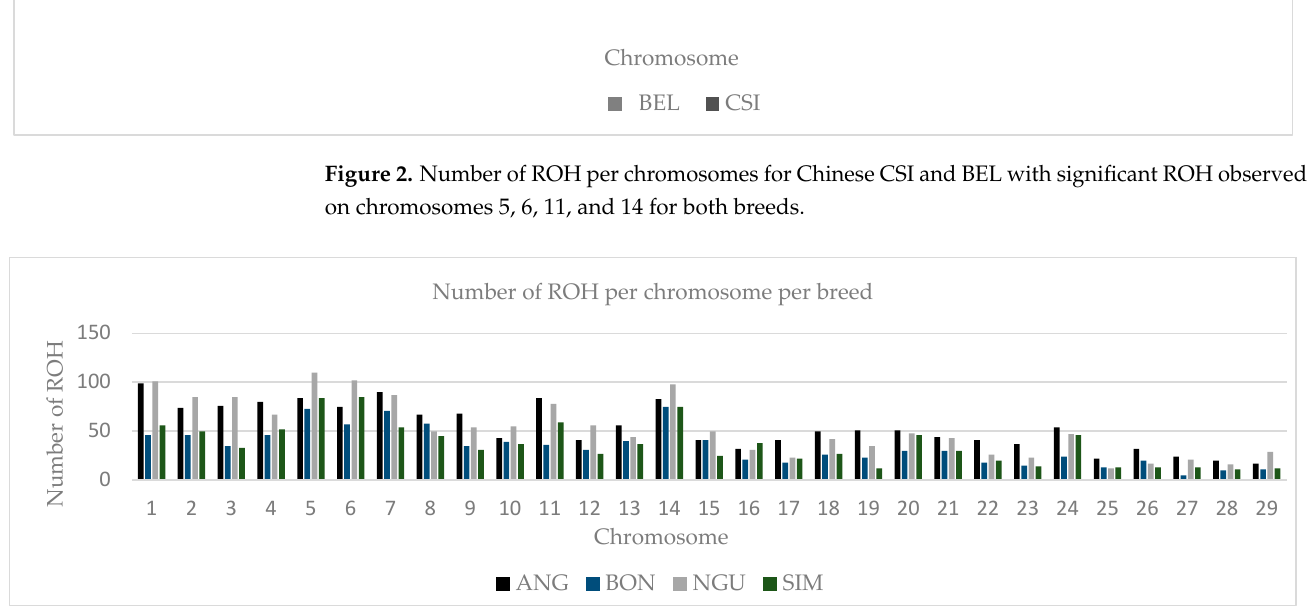
Figure 3. Number runs of homozygosity per chromosomes for South Africa BON, NGU, SIM, and ANG with significant ROH observed on chromosomes 1, 2, 3, 4, 5, 6, 7, 11, and 14, with NGU and ANG showing the most significant chromosome coverage.